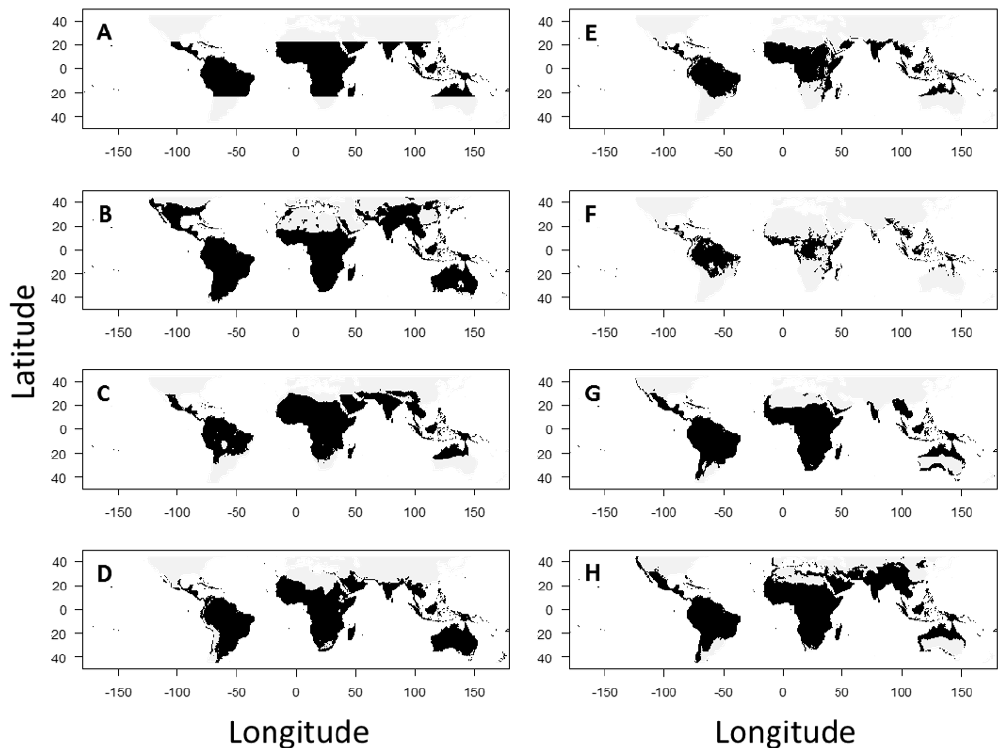
Figure 1. Maps of Earth’s tropical land areas. Maps of the terrestrial tropics (black) as defined under various criteria: (a) Criterion 1 = all areas between 23.4 o S and 23.4 o N; (b) Criterion 2 = all areas with a net positive energy balance; (c) Criterion 3 = all areas where mean annual temperatures does not vary with Latitude; (d) Criterion 4 = all areas where temperatures do not go below freezing in a typical year; (e) Criterion 5 = all areas where the mean monthly temperature is never less than 18 o C; (f) Criterion 6 = all areas where the mean annual “biotemperature” ≥24 o C; (g) Criterion 7 = all areas where the annual range of temperature is less than the average daily temperature range; (h) Criterion 8 = all areas where precipitation seasonality exceeds temperature seasonality. GeoTIFF maps are available as online supplementary files